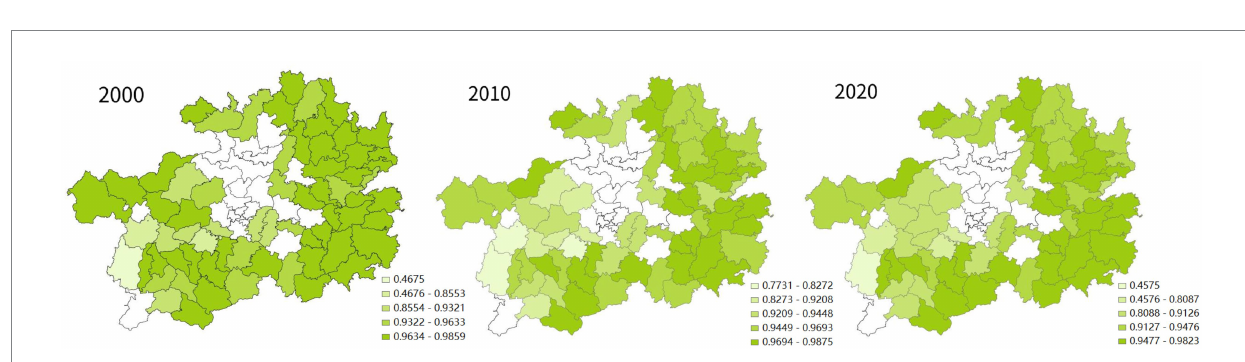
FIGURE 10 Spatial analysis of changes in the environmental QoL of Guizhou’s districts and